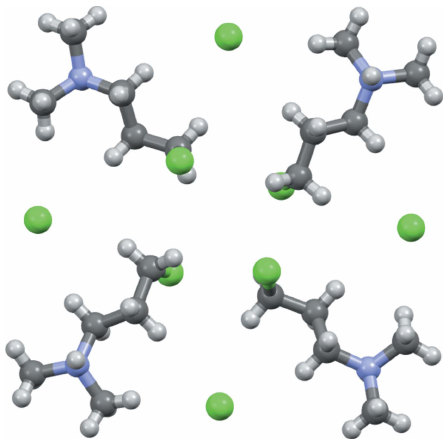
Figure 4 Ball-and-stick diagram of the pinwheel structural motif found in the layer depicted in Fig.